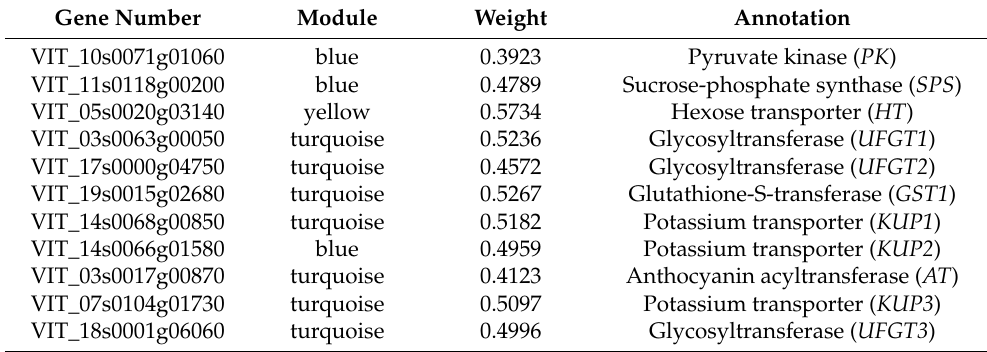
Table 7. Hub genes selected from three co-expressed modules.